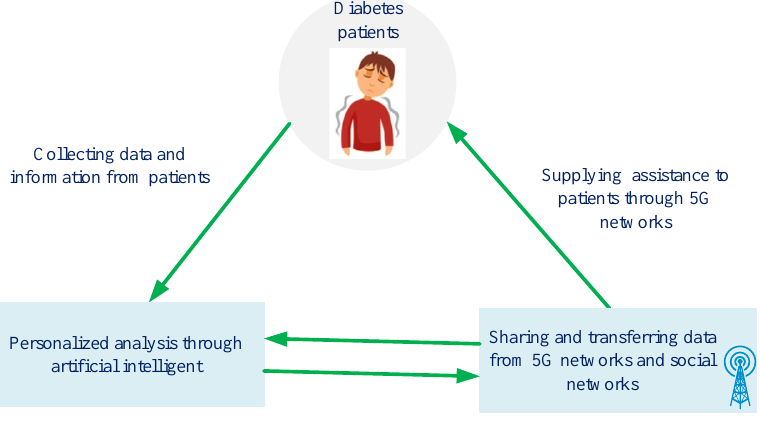
Figure 7. Data sharing